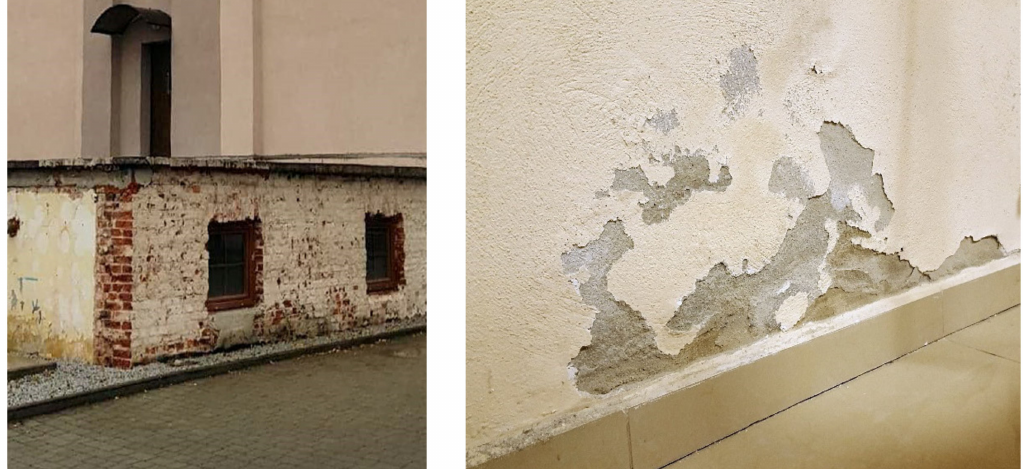
Figure 5. Pictures of selected fragments of the Redemptorist monastery in